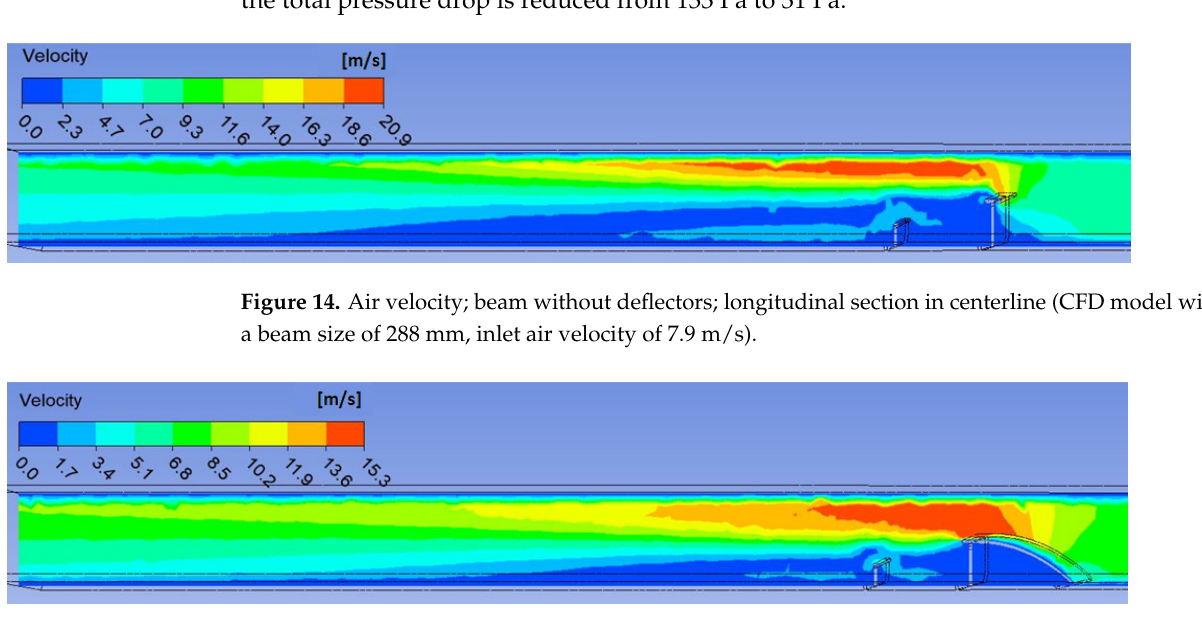
Figure 15. Air velocity, beam with deflector upstream the beam; longitudinal section in the centerline (CFD model with a beam size of 288 mm, inlet air velocity of 7.9 m/s).